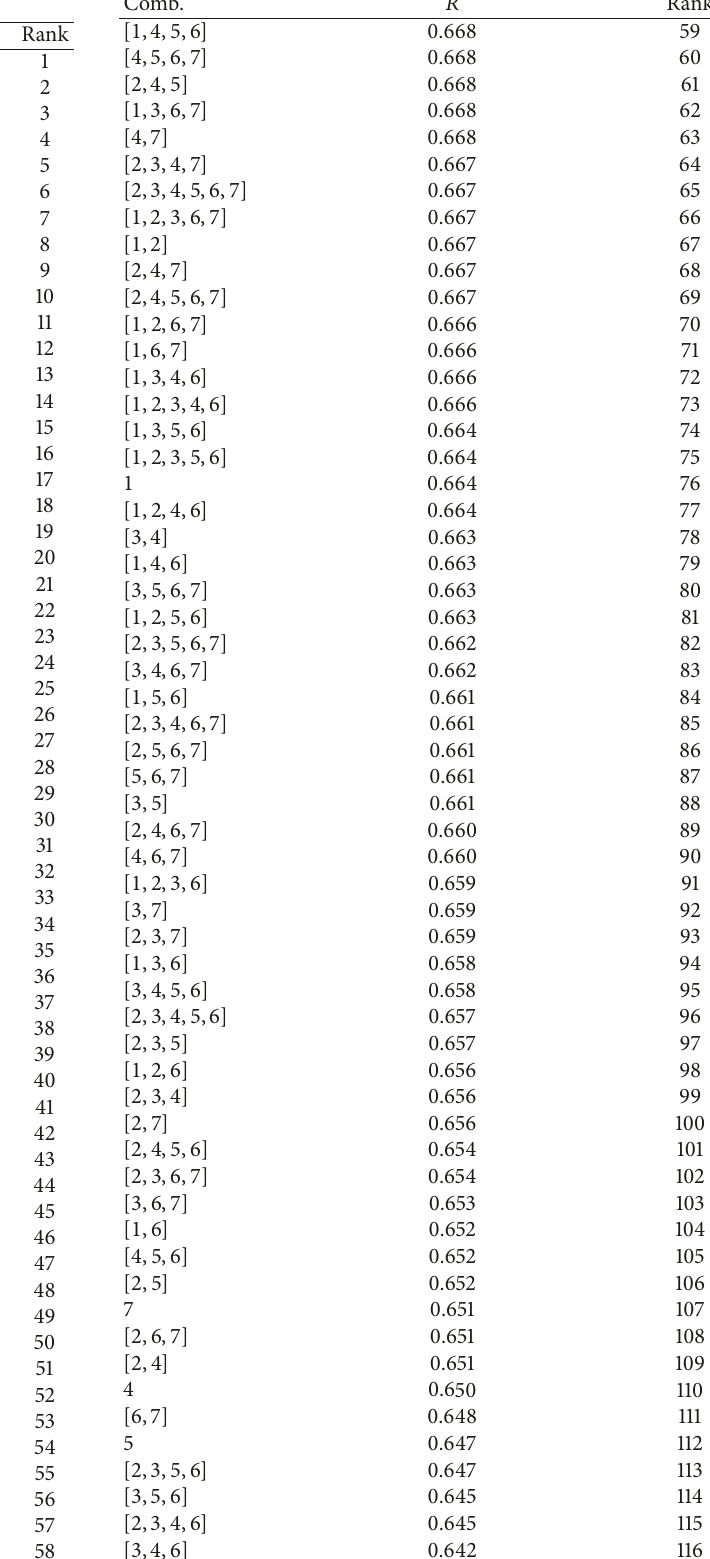
Table 7: Possible models combinations and their rank in the northern part of the domain and lead one